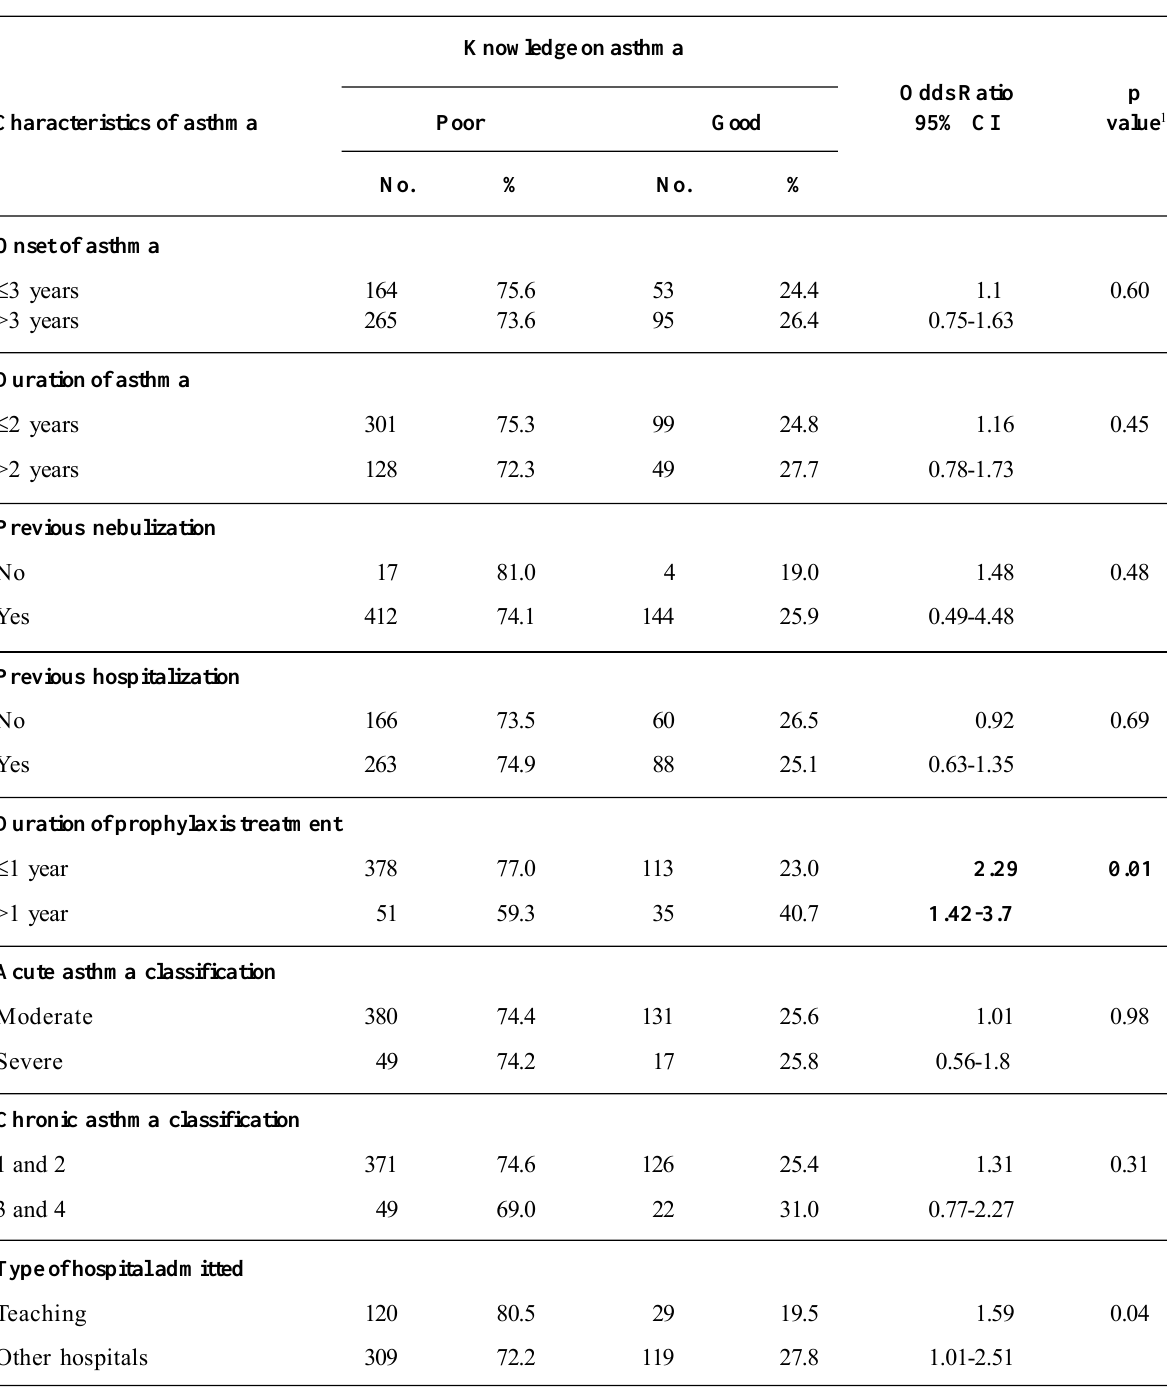
Table 4. Association of the caregivers’ knowledge on asthma with selected